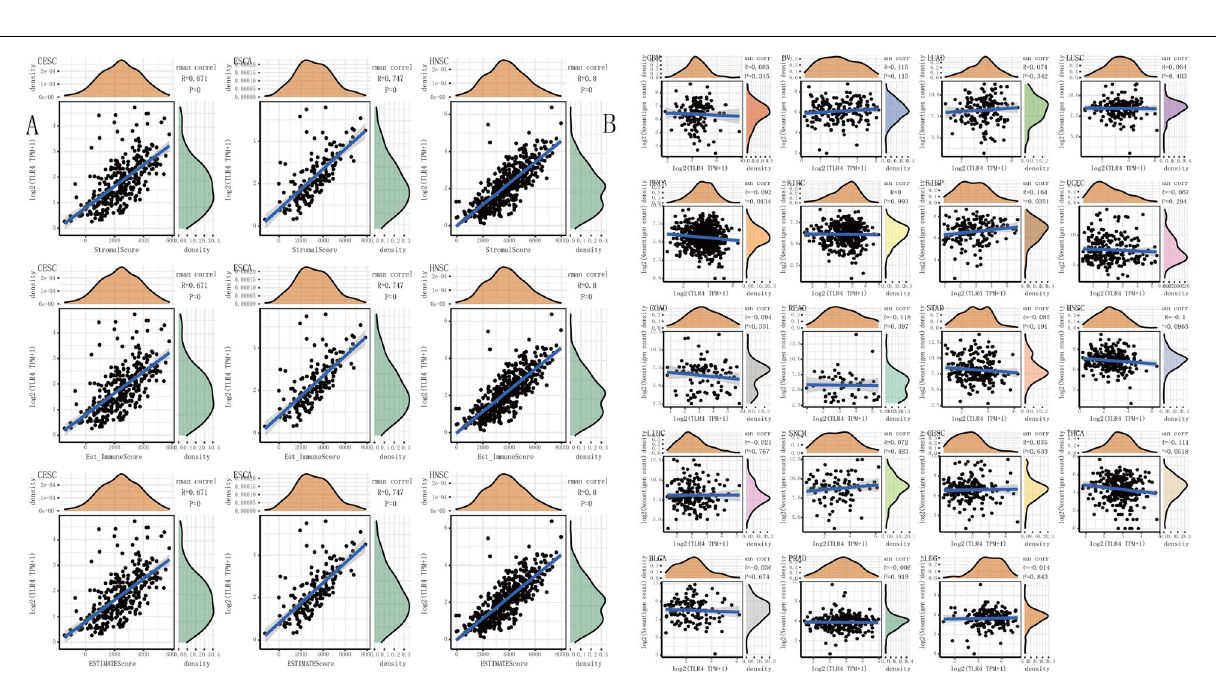
Frontiers in Cell and Developmental Biology |